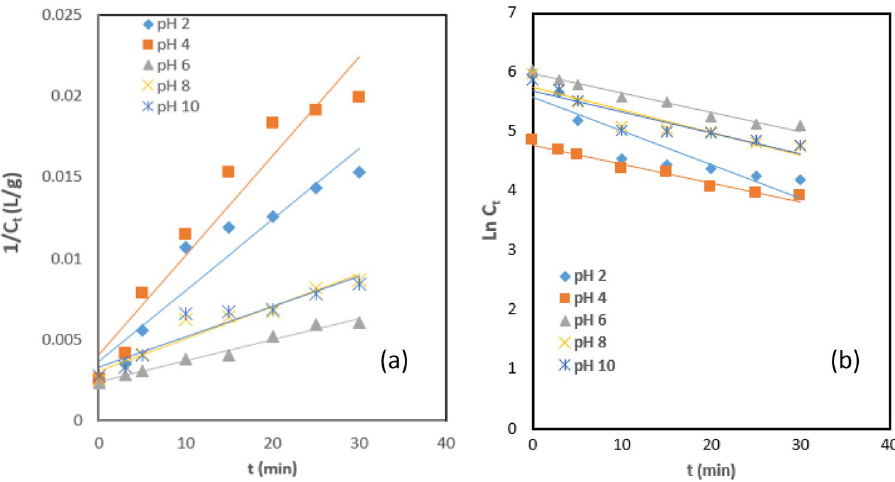
Figure 10. ( a ) First-order and ( b ) Second-order CF kinetics at 0.2 g PNSC L −1 and 303 K.